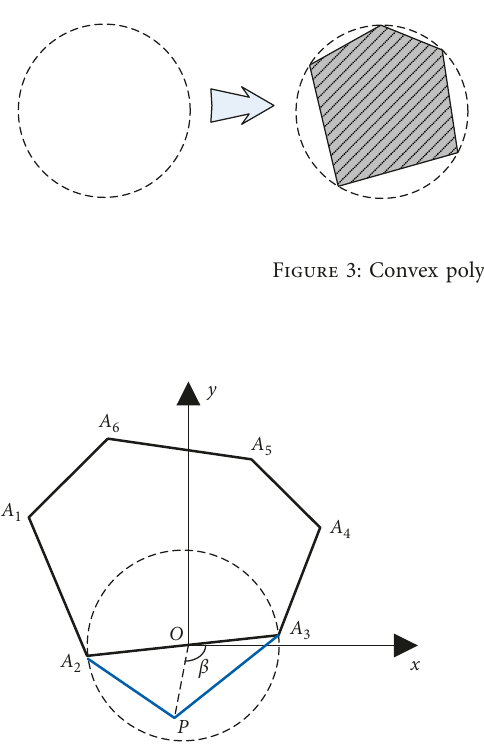
Figure 4: Generation of new